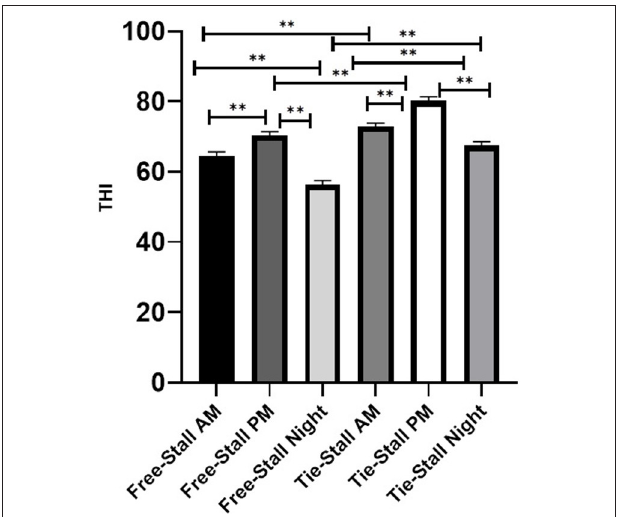
FIGURE 1 | Average temperature humidity index for free-stall vs. tie-stall. Data are presented as least squared means of untransformed data, with error bars representing standard error for each mean. Significance ( P < 0.001 for all comparisons except tie-stall a.m. vs. night p = 0.011) is represented by double stars above the error